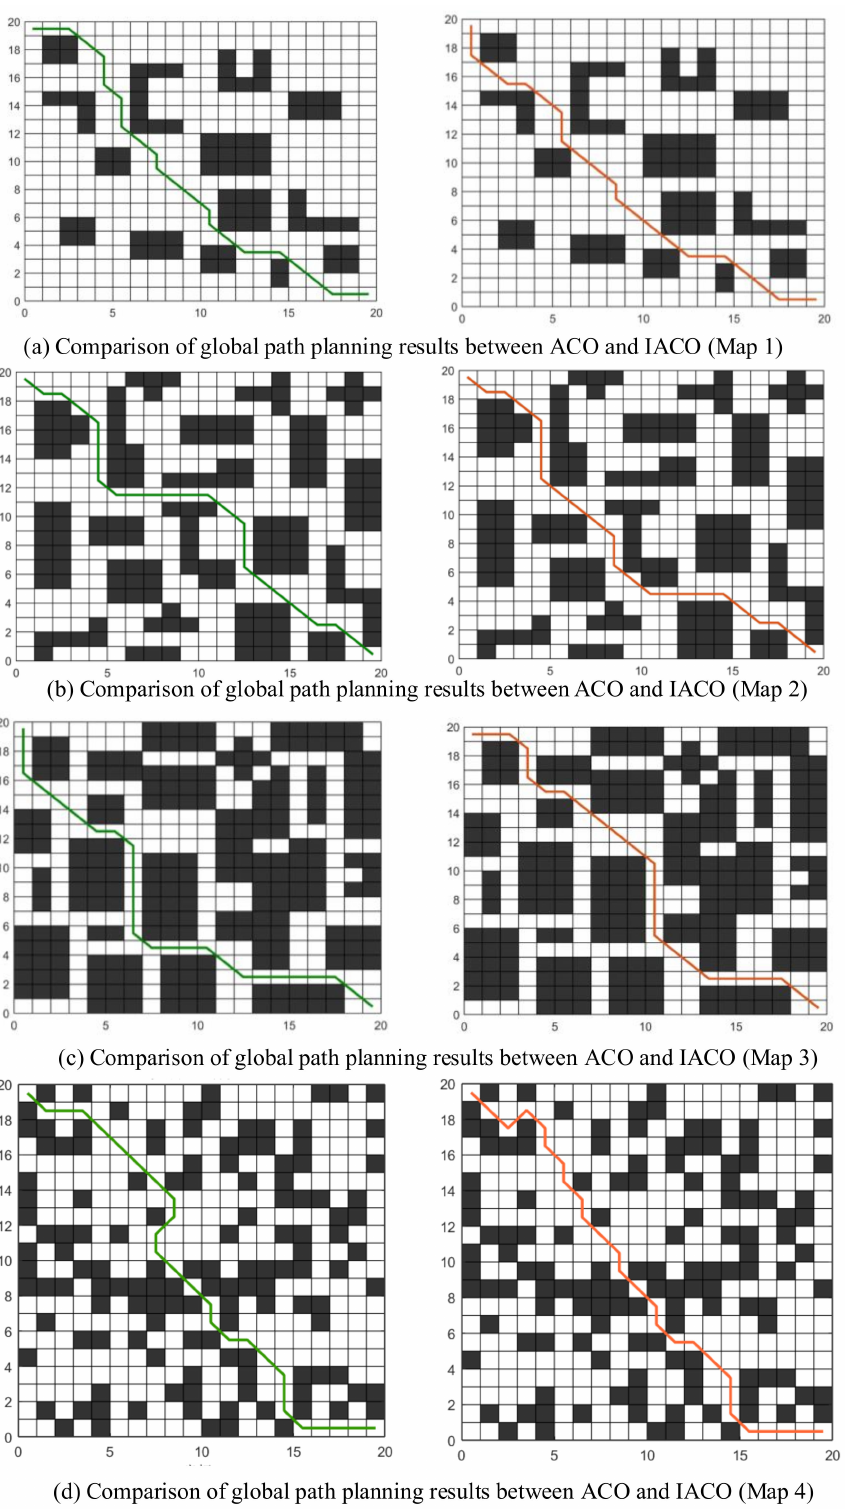
Figure 8. Comparison of global path planning results between ACO ( left ) and IACO ( right